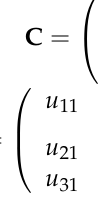
Figure 4. HI construction based on fuzzy clustering. The performance parameters obtained by feature extraction have a certain spatial po- sition relationship with the change in the degradation stage. The input data are two-di- mensional time series X.